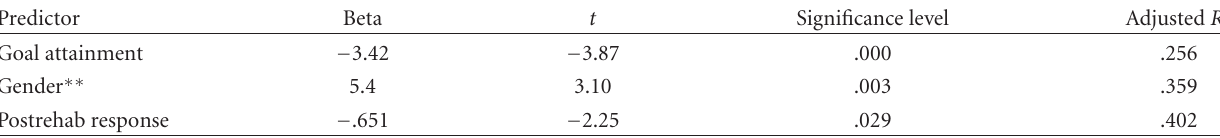
Table 3: Significant variables using stepwise regression analysis to predict psychosocial distress ∗ .